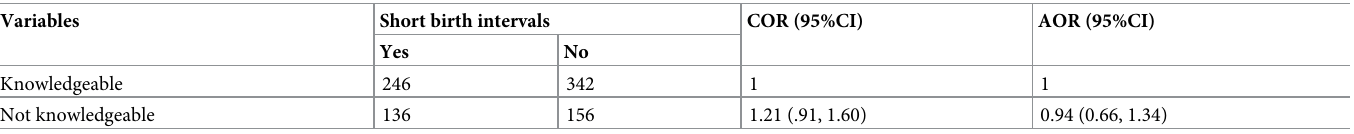
S1 Table. Amharic and English version of the